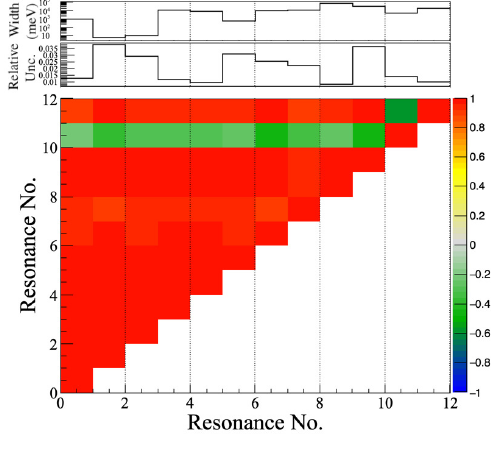
Figure 6. Obtained correlations between neutron widths of all fitted resonances.